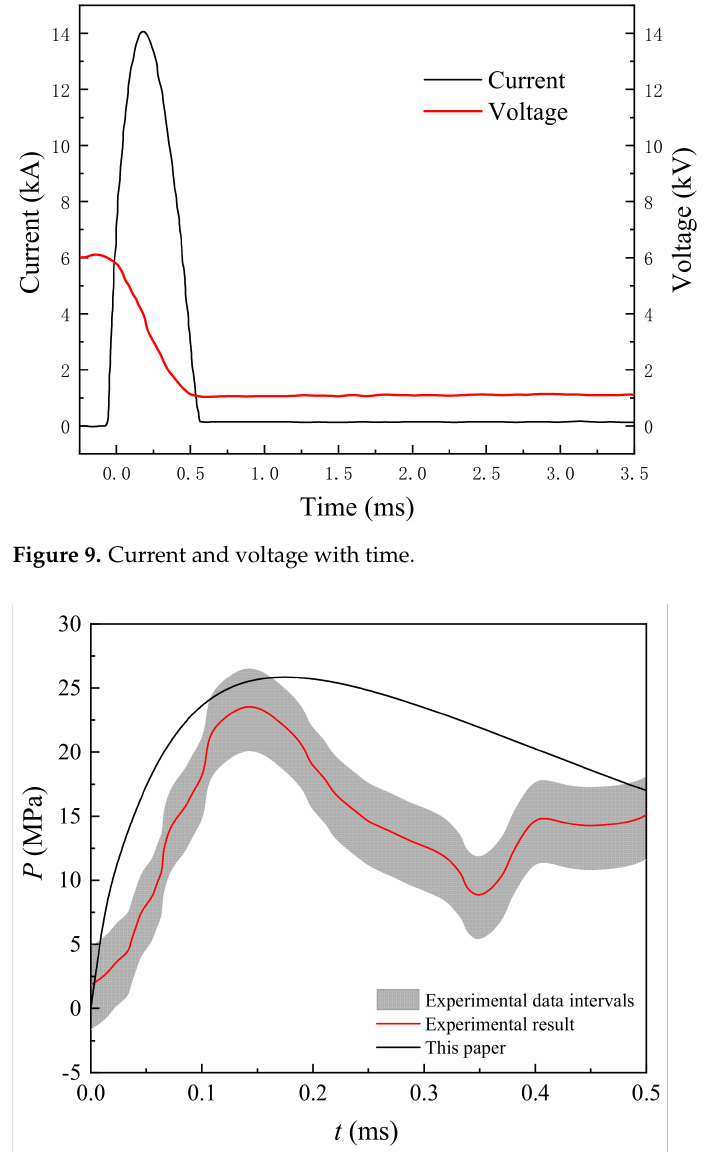
Figure 10. Comparison of the present analytical model and the experimental data from Park et al. (2011).